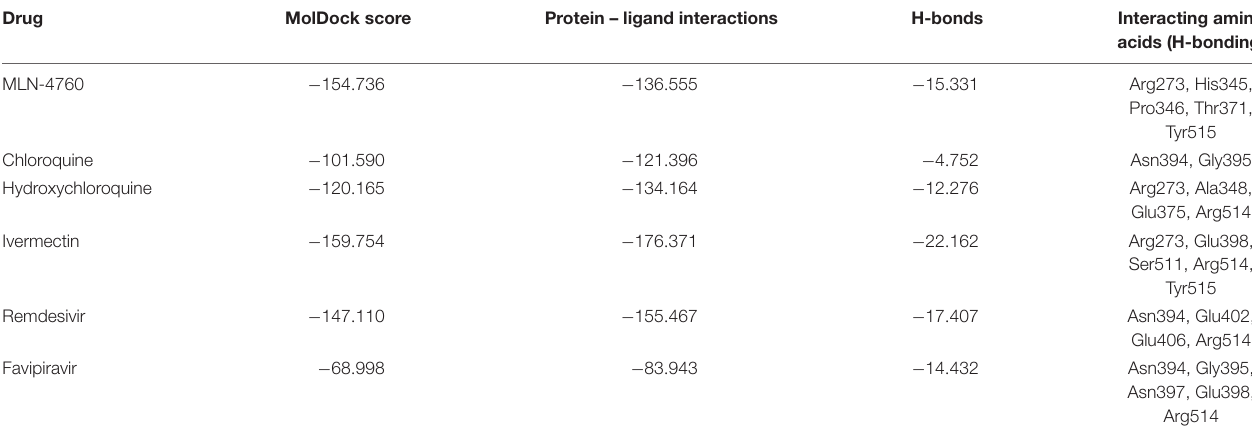
TABLE 5 | Docking scores of different drugs against human ACE-2 protein.